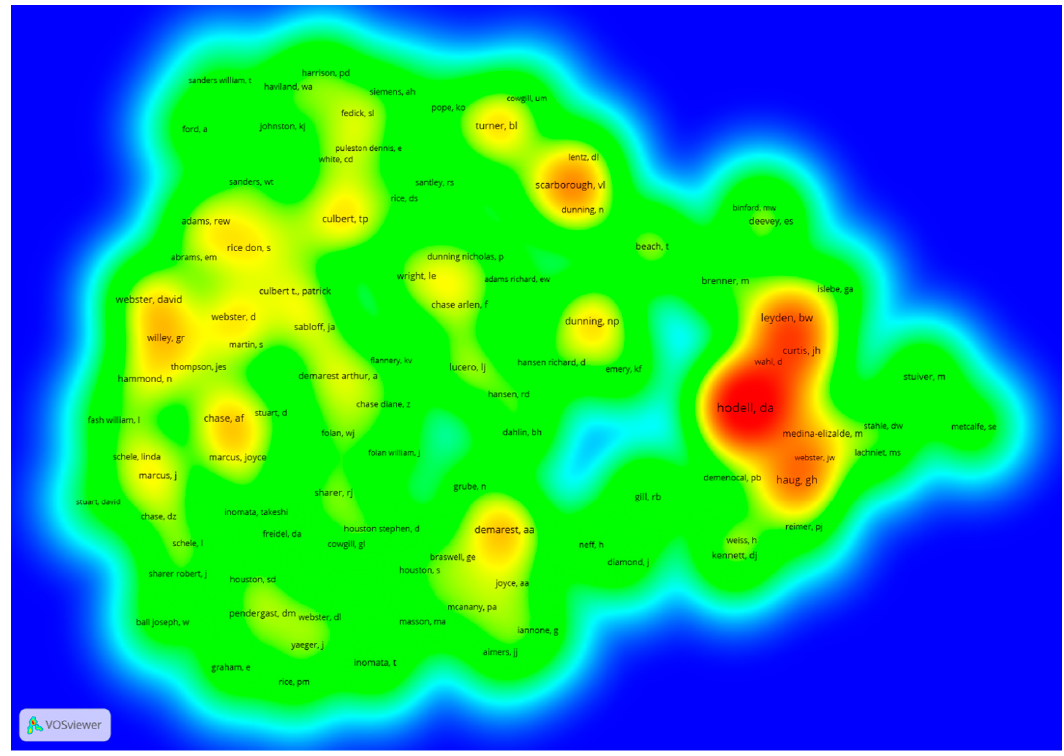
Figure 4. Co-citation map of the first-authors from the 433 Maya collapse papers (the minimum number of co-citations is 30). Source: WoS. VOSviewer.